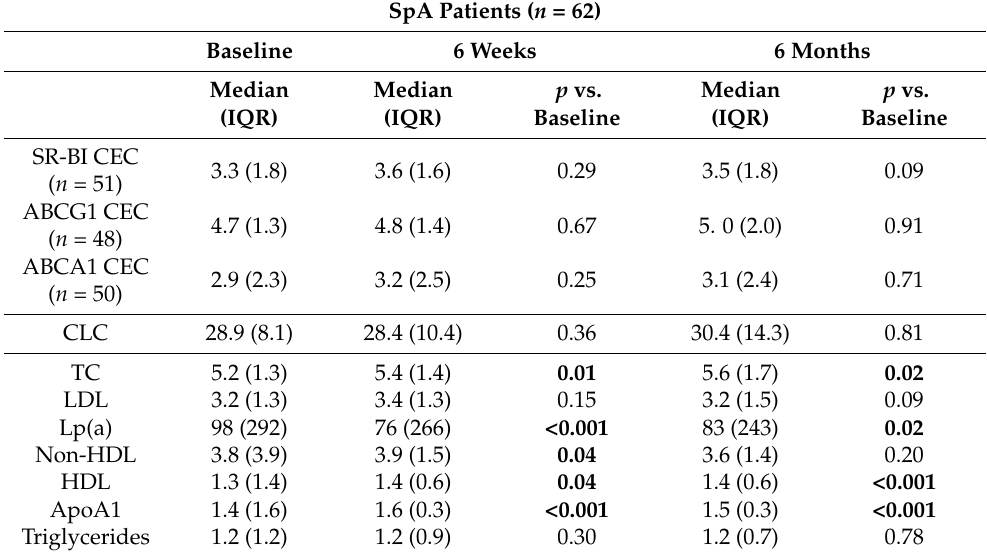
Table 2. Functional lipid parameters and serum lipid levels in SpA patients. SpA Patients ( n =